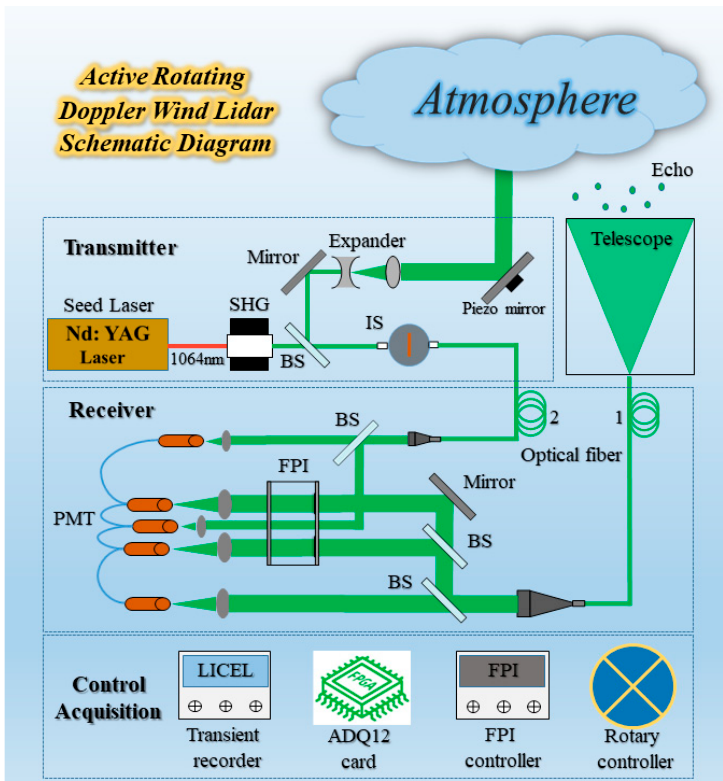
Figure 2. The overall design of the Doppler wind Lidar.